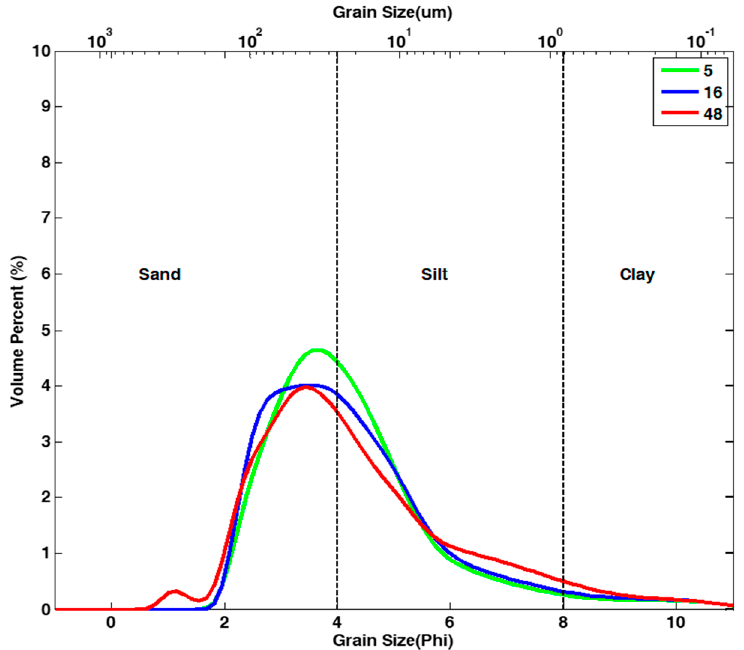
Figure 8. Grain size distributions of three sandy samples with the grain size near the classification boundary. Numbers 5, 16, and 48 are sample IDs. See the locations of these samples in Figure